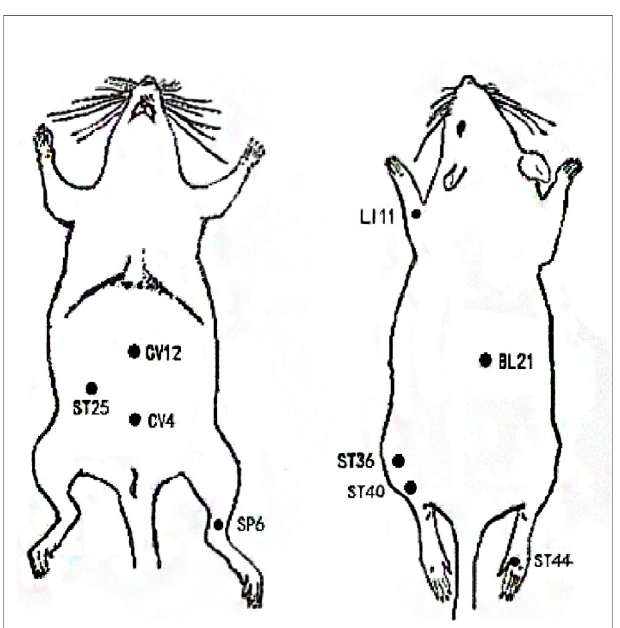
FIGURE 3 | Locations of frequently chosen acupoints in obese